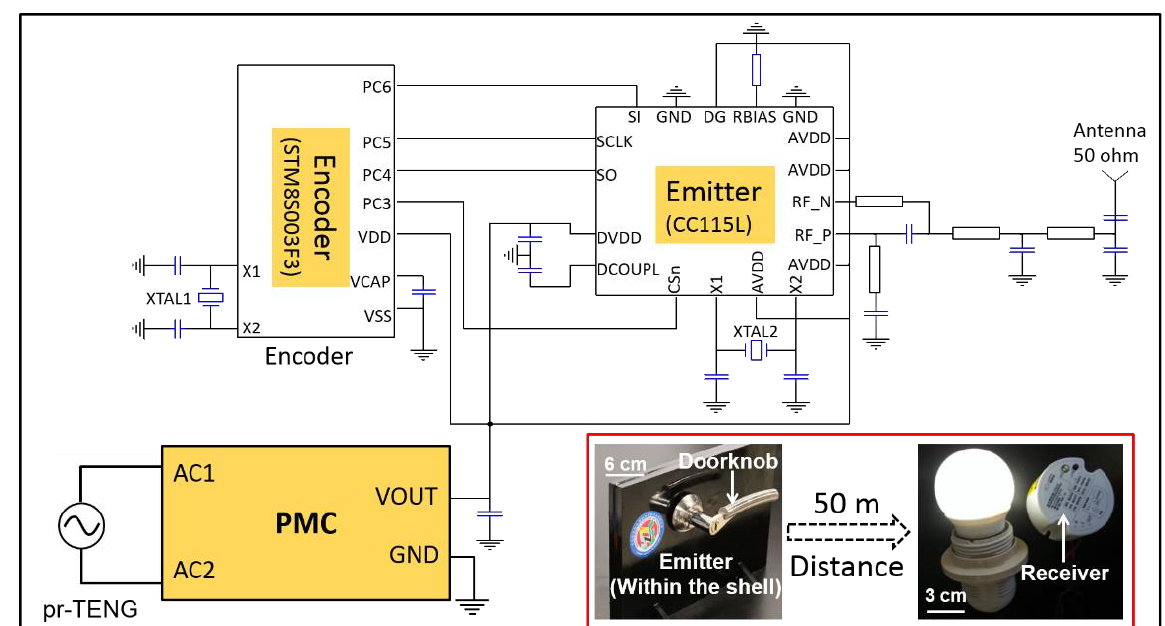
Figure 5. Circuit diagram of the self-powered RF transmission system and the demonstration of remote control.